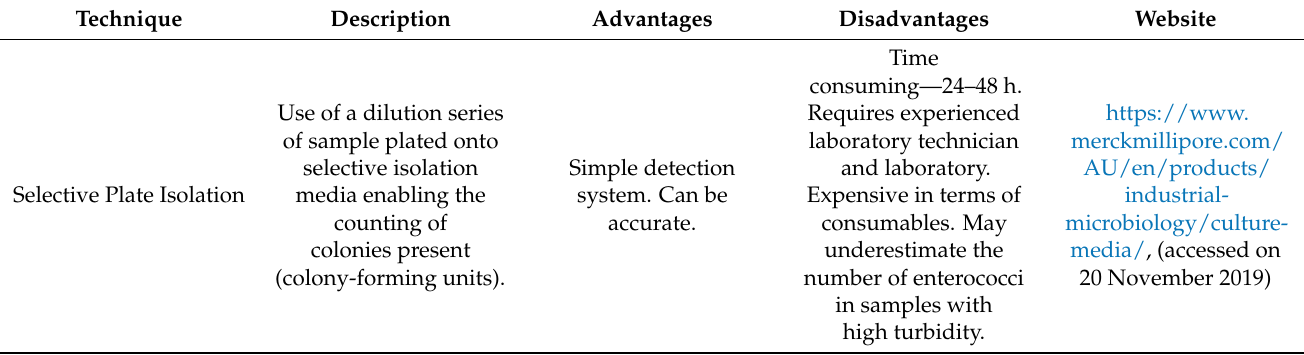
Figure 5. Confirmation of the presence of E. faecalis in Lang Lang wastewater. Lanes M and 11: molecular marker, Lanes 1–8: RPA-AGE of Lang Lang wastewater neat, 10 − 1 , 10 − 2 , 10 − 3 , 10 − 4 , 10 − 5 , 10 − 6 , 10 − 7 . Lanes 12–19: PCR of Lang Lang wastewater neat, 10 − 1 , 10 − 2 , 10 − 3 , 10 − 4 , 10 − 5 , 10 − 6 , 10 − 7 . Table 3. A comparison of the advantages and disadvantages of current methods to identify and enumerate